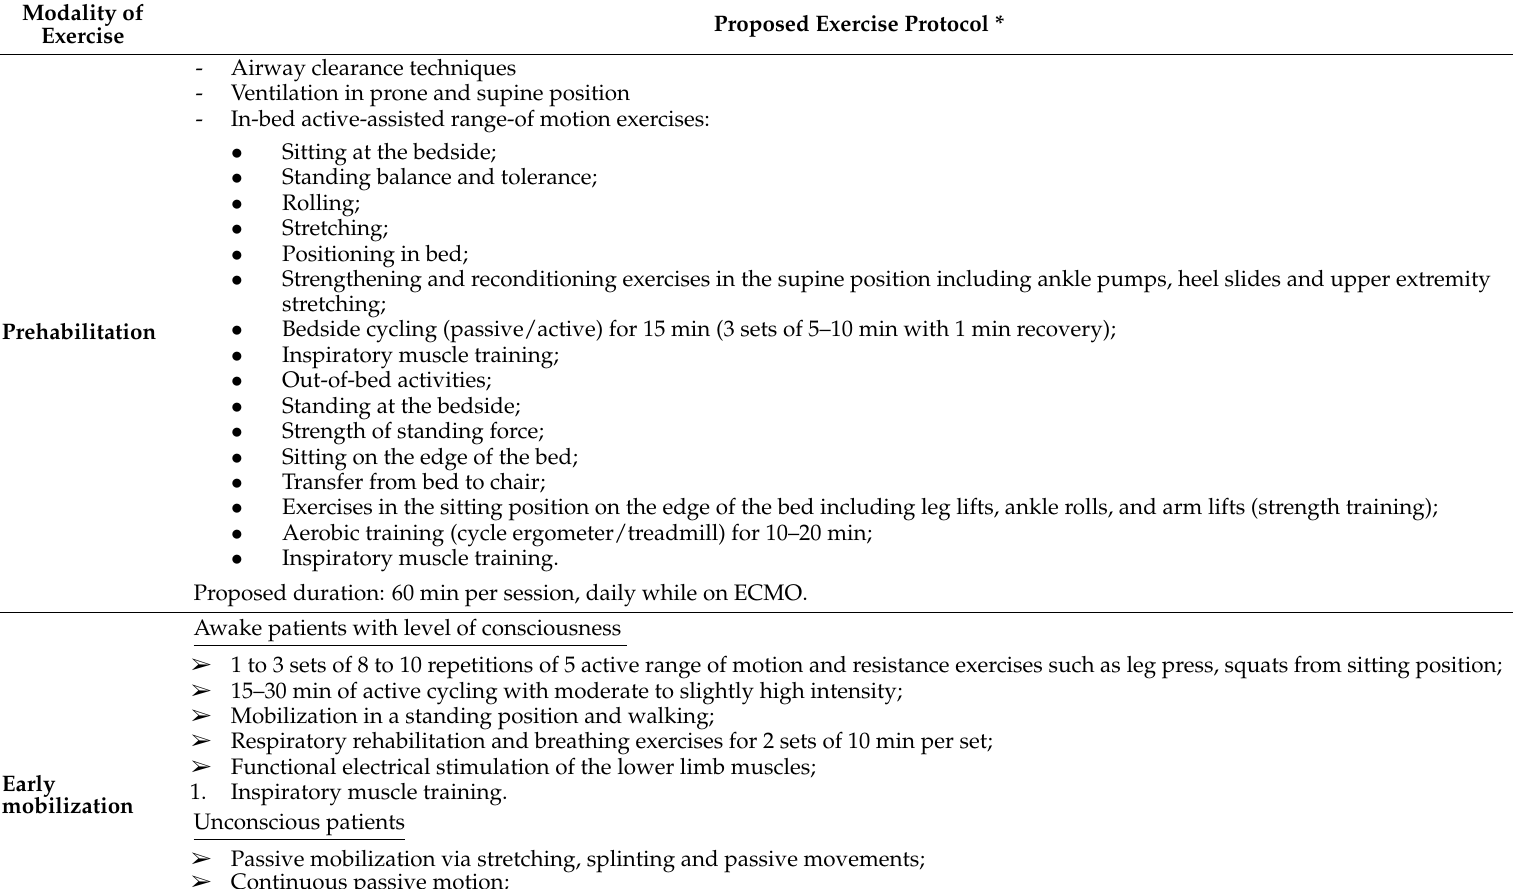
Table 2. Modalities of exercise training, proposed protocols, and suggested